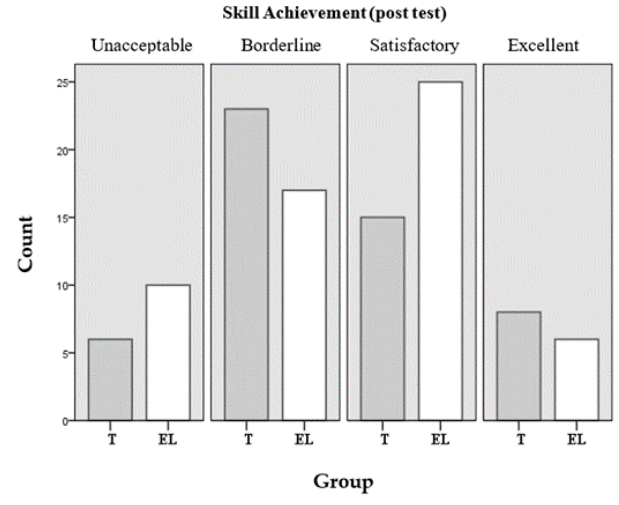
Figure 5. Achievement levels in technical skills (post-test).